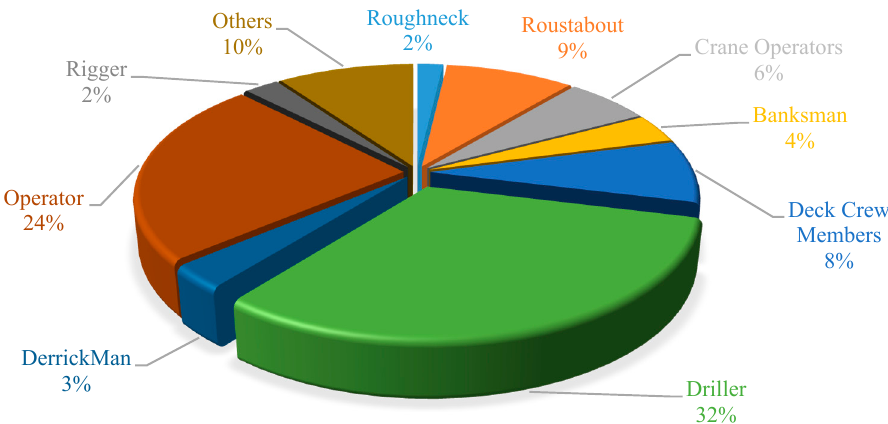
Figure 2. Main actor in the chain of events.